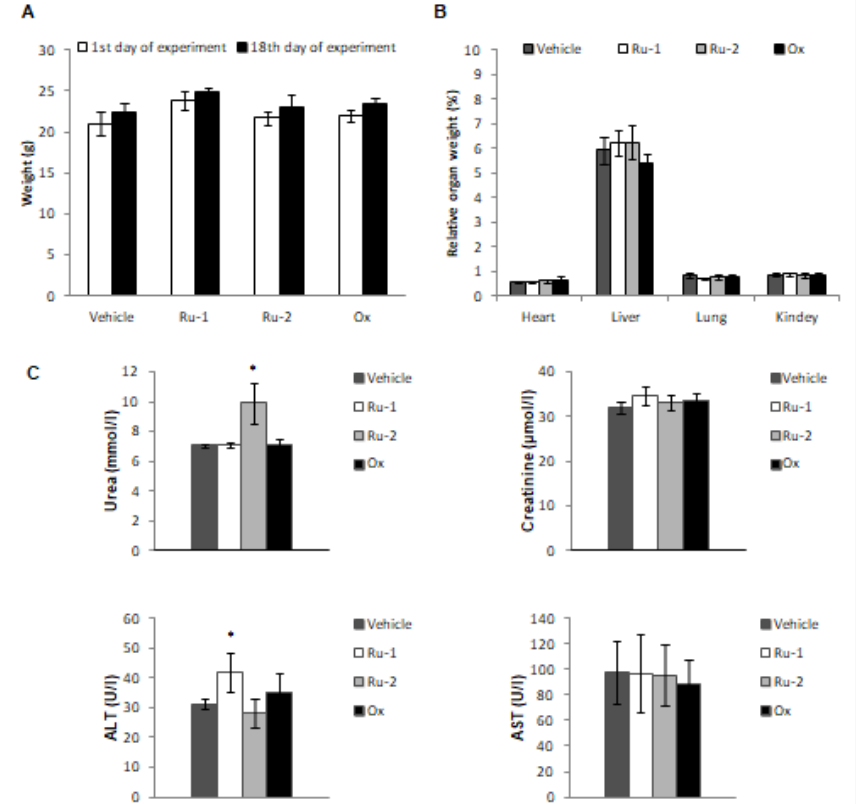
Figure 9. Evaluation of systemic toxicity caused by i.p. application of ruthenium(II) terpyridine complexes. ( A ) Body mass of tumor-bearing mice before and after administration of ruthenium(II) terpyridine complexes and oxaliplatin. ( B ) The relative mass of isolated organs of tumor-bearing mice after the administration of ruthenium(II) terpyridine complexes and oxaliplatin. ( C ) Concentration of urea, creatinine, ALT, and AST in the serum of tumor-bearing mice after treatment with ruthenium(II) terpyridine complexes and oxaliplatin. The data are expressed as mean ± SD and were analyzed by a Student’s t test, * p <